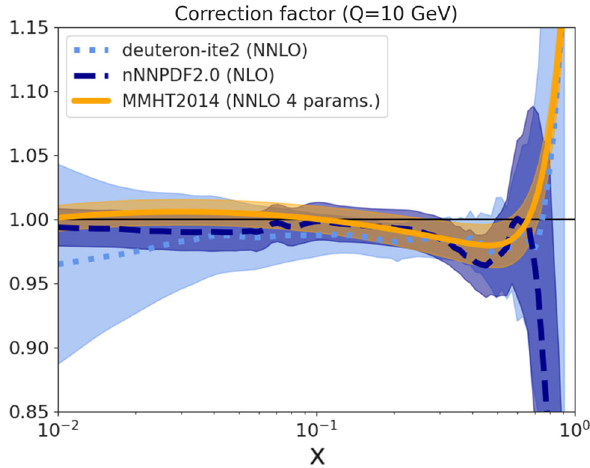
/ F p ,calculatedusingourfinal 2 2